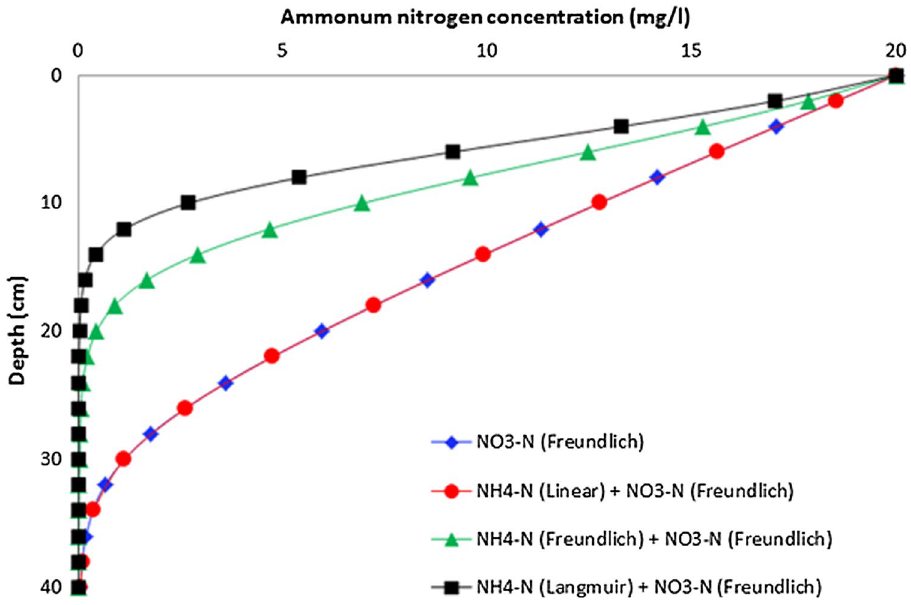
Fig. 8 Concentration of ammonium nitrogen in the pres- ence of various isotherms by ammonium nitrogen and nitrate nitrogen (refer to Tables 2 and 3 for other